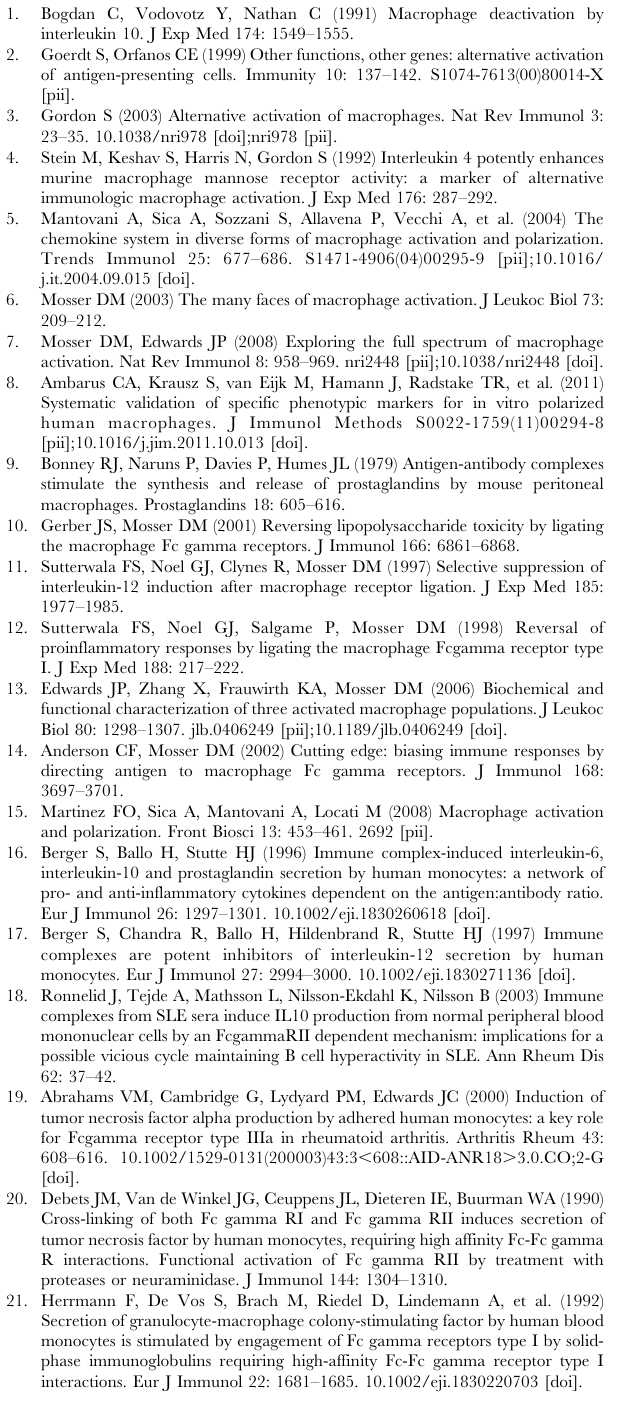
Figure S1 Expression of TLR2 and TLR4 on M W IFN- c , M W IL-4 , and M W IL-10 . Healthy peripheral blood monocytes were cultured for 4 days in medium or in medium supplemented with IFN- c , IL-4, or IL-10. Expression TLR2 and TLR4 was measured by flow cytometry. Bars represent the mean 6 SEM of 4 independent experiments. *p , 0.05, **p , 0.01